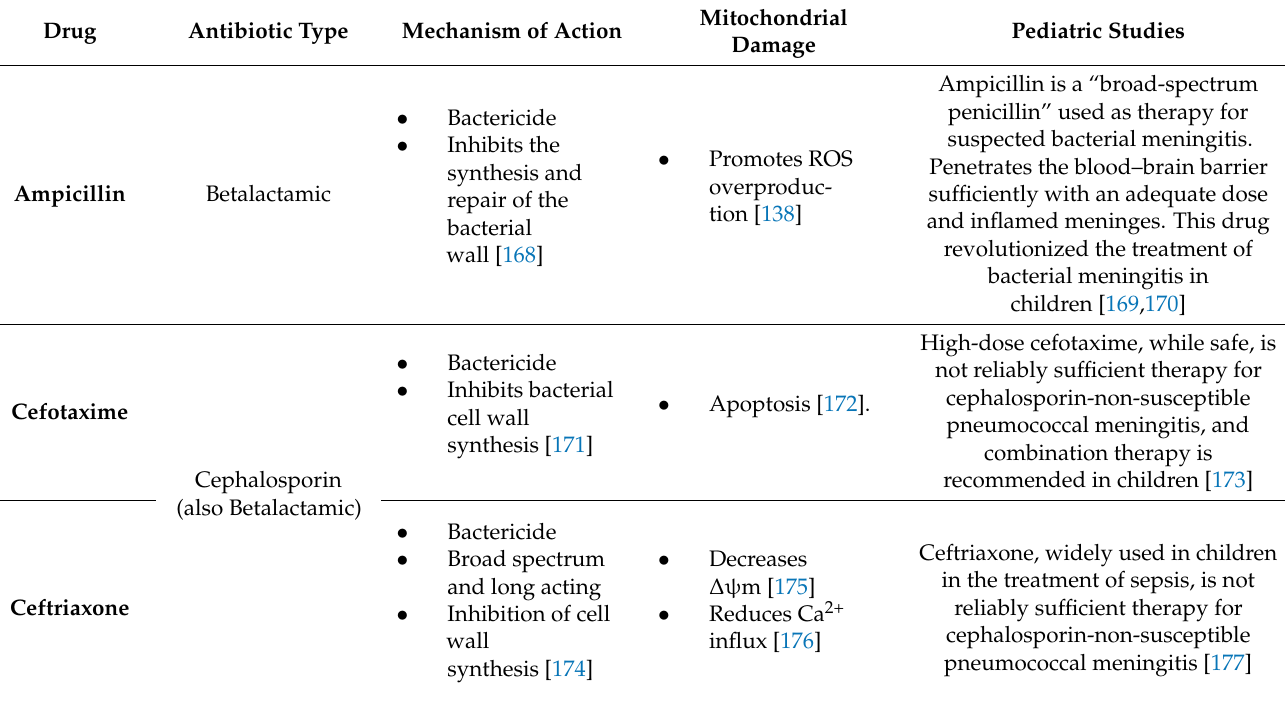
Table 6. Antibiotic therapy against bacterial meningitis infection and associated mitochondrial effects. Drug Antibiotic